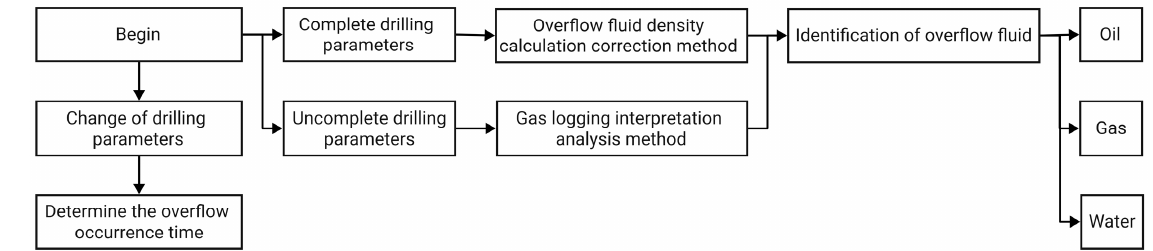
Figure 6. The process of identifying overflow fluid type.